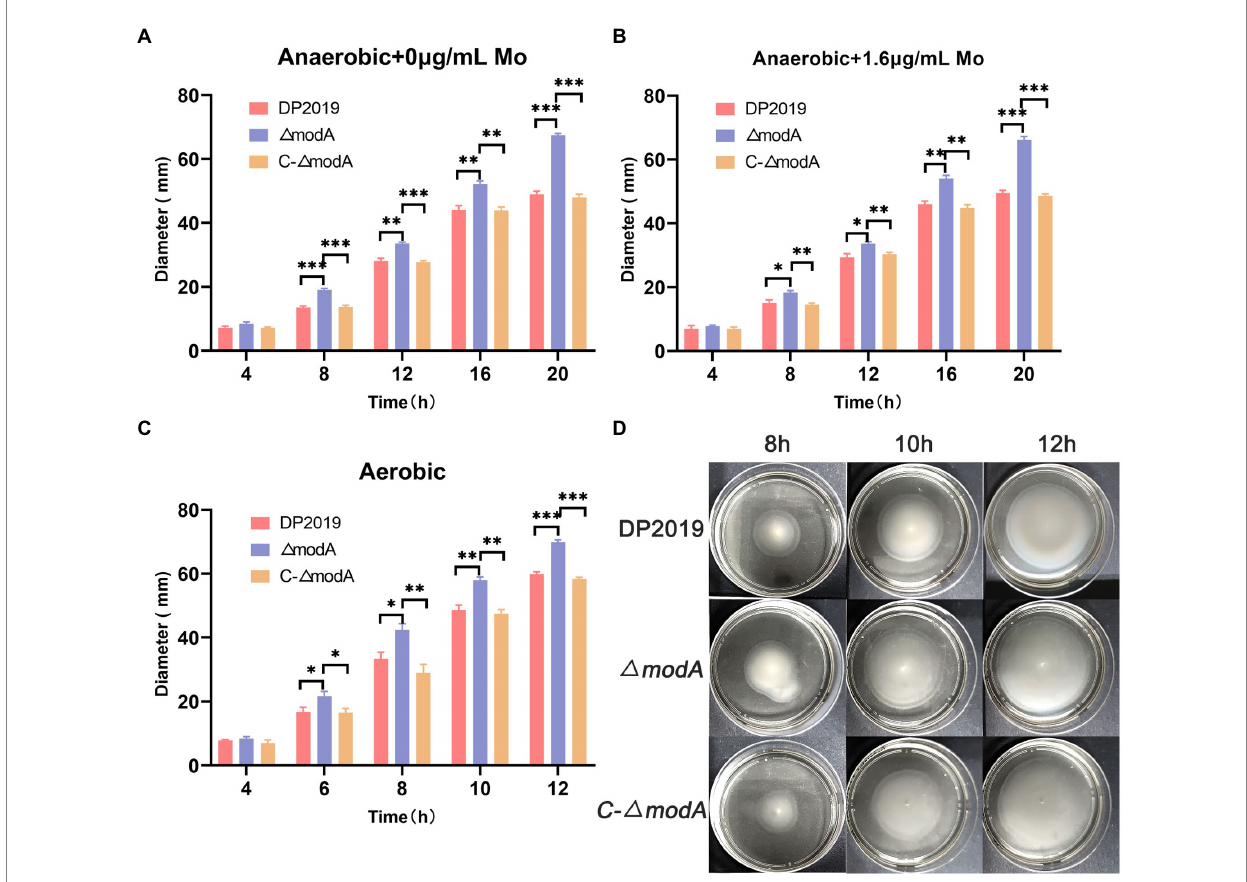
FIGURE 3 Examination of swimming motility. (A) Line graph showing swimming migration distances under anaerobic growth conditions. (B) Line graph showing swimming migration distances under anaerobic growth conditions with 1.6 μ g/mL molybdate supplement to avoid the interference of anaerobic growth defects on the results. (C) Line graph showing swimming migration distances under aerobic growth conditions. (D) Halo images of bacteria swimming on agar plates under aerobic growth conditions. Data are presented as the mean ± S.D. of three independent experiments, * p < 0.5, ** p < 0.01, *** p <